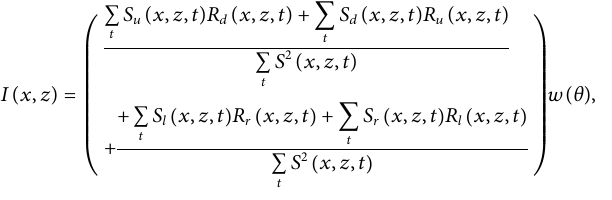
FIGURE 8 | RTM section for Marmousi-II model: (A) conventional RTM; (B) RTM with wave fi eld decomposition based on the Poynting vector; (C) RTM with wave fi eld decomposition based on the optical fl ow vector; (D) angle-weighted RTM with wave fi eld decomposition based on the optical fl ow vector.